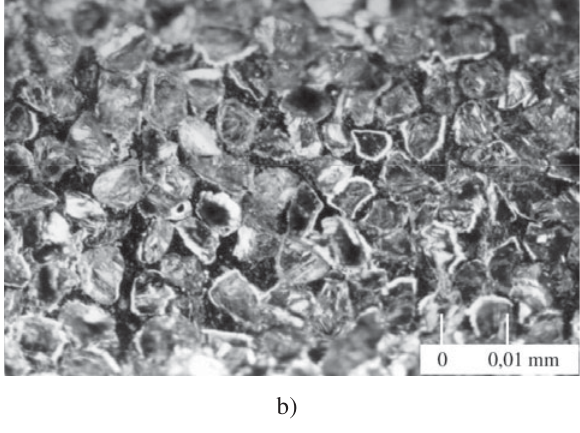
Figura 3. Ponta diamantada sem esterilização.